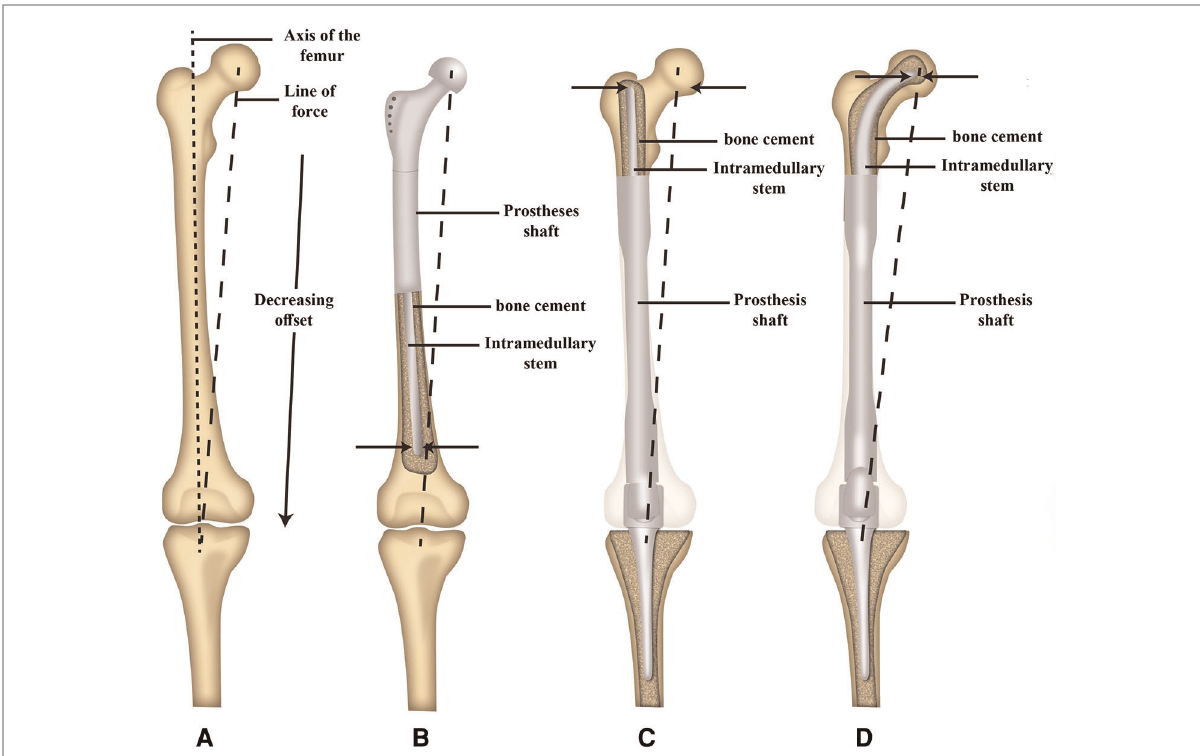
FIGURE 6 Schematic illustration of the offset distance between the line of force and the long axis of the femur and the offset distance of the tip of intramedullary stem between a proximal and distal femoral replacement. ( A ) The offset distance between the line of force and the long axis of the femur. ( B ) The offset distance of the tip of the intramedullary stem of proximal femoral replacement. ( C ) The offset distance of the tip of the intramedullary straight stem of distal femoral replacement. ( D ) The offset distance of the tip of the intramedullary curved stem of distal femoral replacement. [Adapted from ref. (26) with